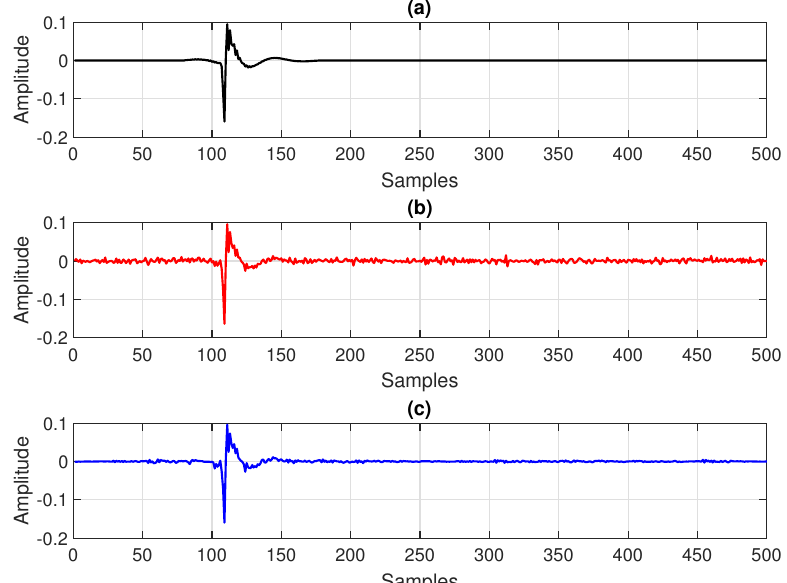
Figure 12. Performance of the conventional RLS filter [with λ = 1 − 1/ ( KL /2 ) ] and the RLS-SF [with λ 1 = 1 − 1/ ( 2 KPL 1 ) , λ 2 = 1 − 1/ ( 2 KPL 2 ) , and P = 3], using K = 10, for the identification of the network echo path from Figure 1b. ( a ) The true network impulse response, ( b ) estimated impulse response (after 5 s) with the conventional RLS filter, and ( c ) estimated impulse response (after 5 s) with the RLS-SF. Other conditions are the same as in Figure